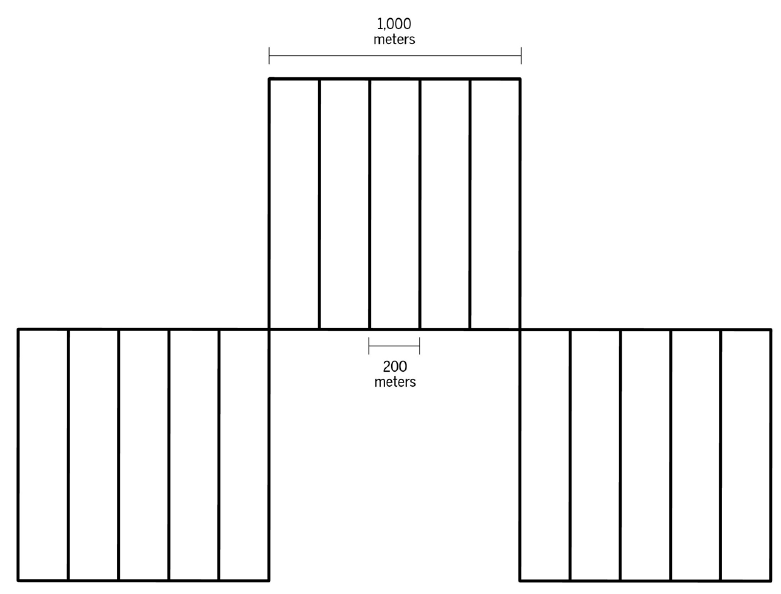
Figure 2. Nest density field plot.